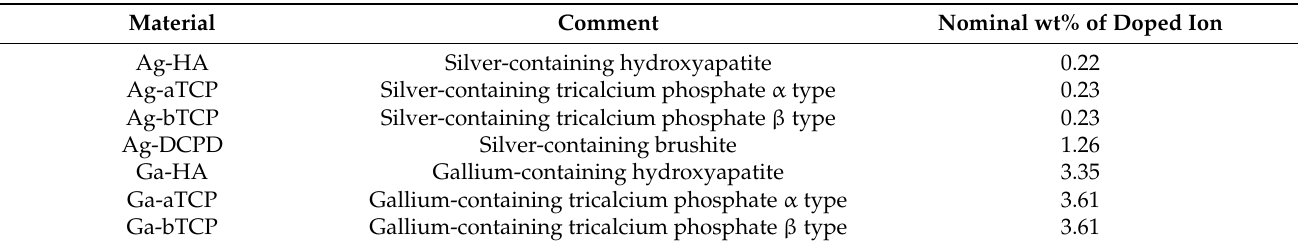
Table 1. List of all synthesized calcium phosphate powders with the estimated number of doped